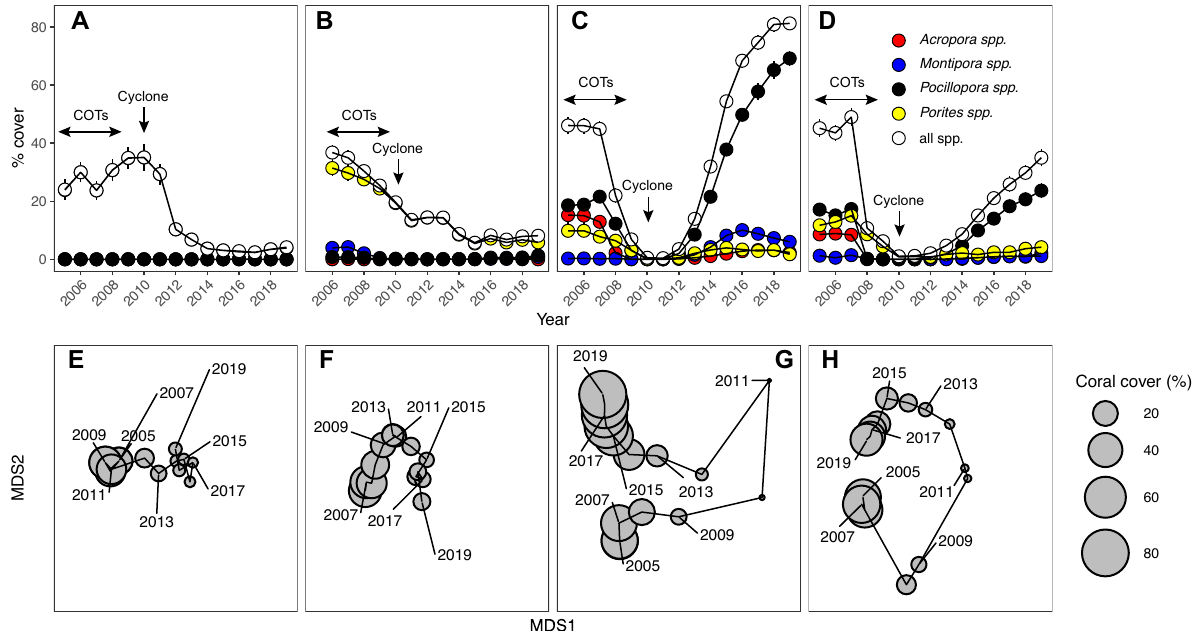
Figure 2. Changes over time in coral cover and community structure across habitats at LTER 1: ( A , E ) fringing reef, ( B , F ) back reef, ( C , G ) 10-m depth on the fore reef, and ( D , H ) 17-m depth on the fore reef. ( A – D ) Mean cover (± SE) of the most abundant corals, and ( E – H ) non-metric multidimensional scaling (NMDS) of coral community structure over time, with circle size showing the summed percent cover for all corals. For fringe and fore reef habitats, N = ~ 40 year −1 , and for back reef, N = 5 year −1